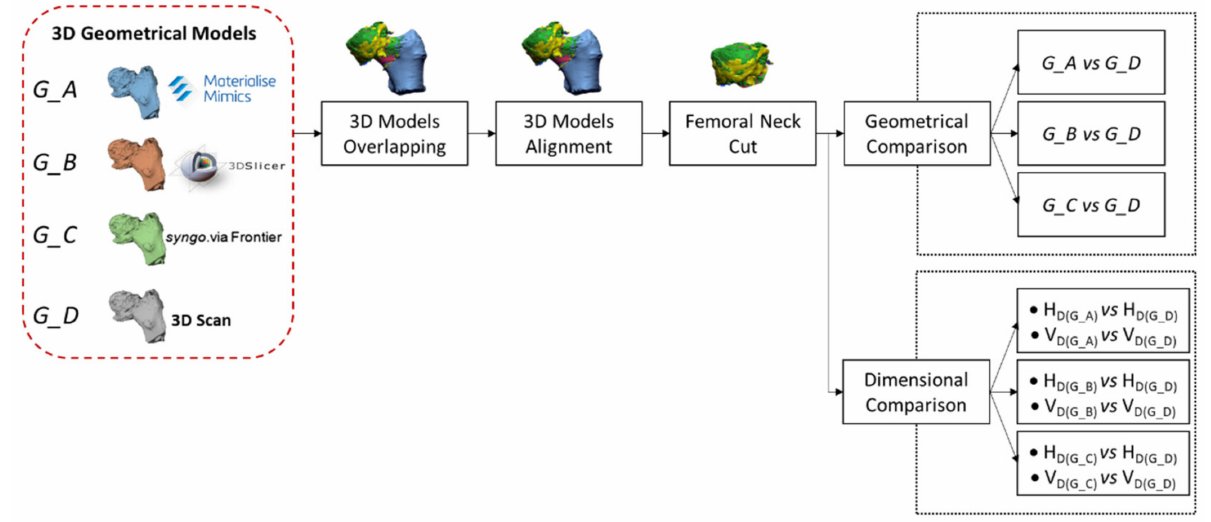
Figure 1. Pipeline’s part 1: Methodology for obtaining the 3D anatomical models to be compared (from the pre-surgery in vivo femoral heads and post-surgery in vitro bony specimens).